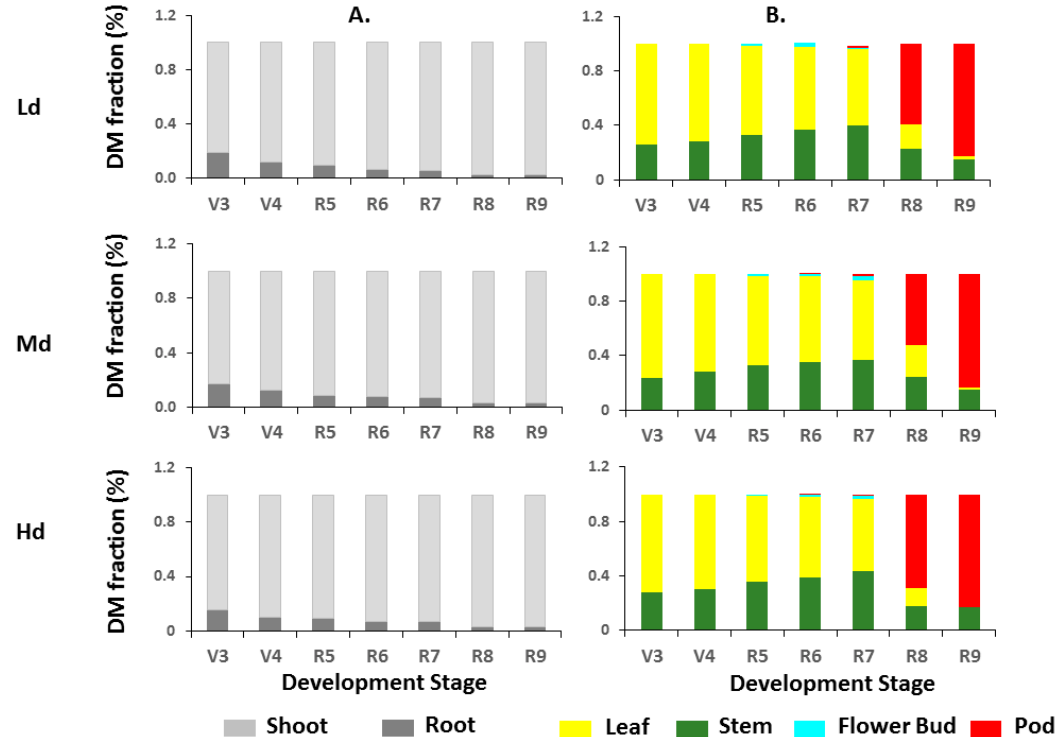
Figure 5. Average fractions ( A ) of roots and shoots in total biomass and ( B ) distribution of shoot biomass over leaves, stems, flower buds and pods of growth habit III Pinto Satillo dry bean ( Phaseolus vulgaris L.) cultivar established at 90,000 plants ha − 1 (Ld, Ld), 145,000 plants ha − 1 (medium density, Md) and 260,000 plants ha − 1 (high density, Hd) under rainfed conditions during the 2011 growing season in Pabellon de Arteaga, Aguascalientes, Mexico.